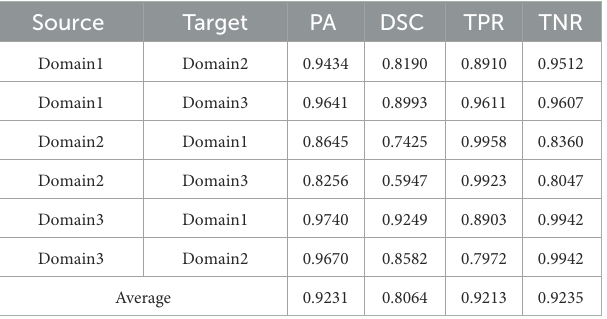
TABLE 7 Results on ultrasound thyroid nodule datasets with ours.